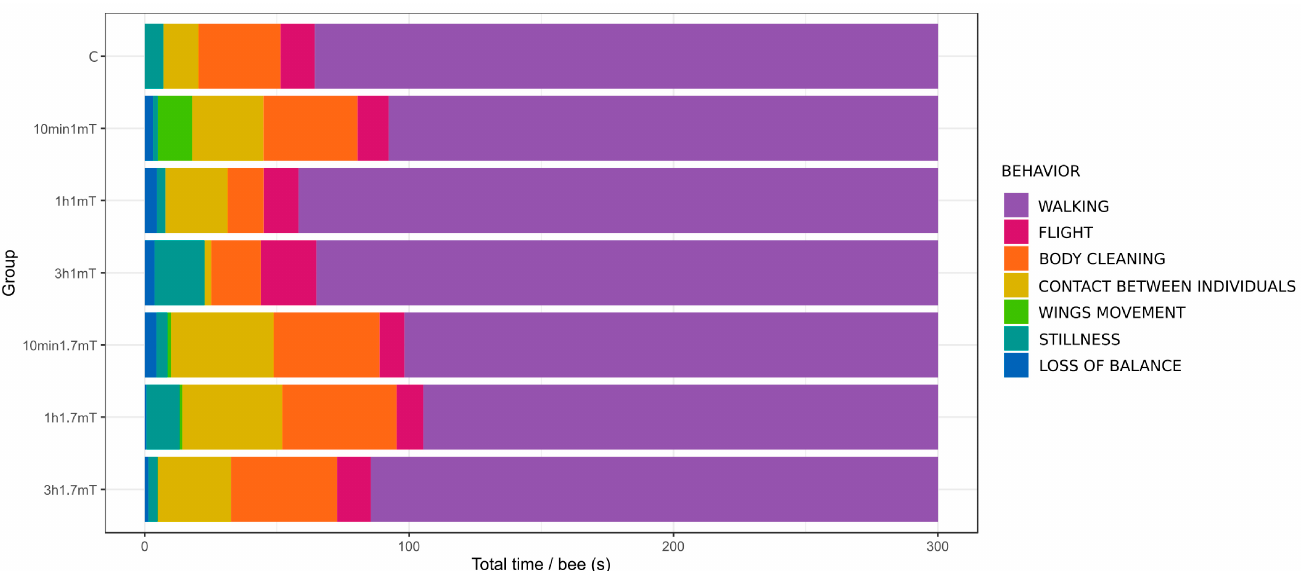
Figure 1. Mean time spent on behavior per bee in 5 min trial. The name of the group is a combination of time of exposure and intensity of the magnetic field, for example, 10 min 1 mT—bees were exposed for 10 min at 1 mT magnetic field intensity.